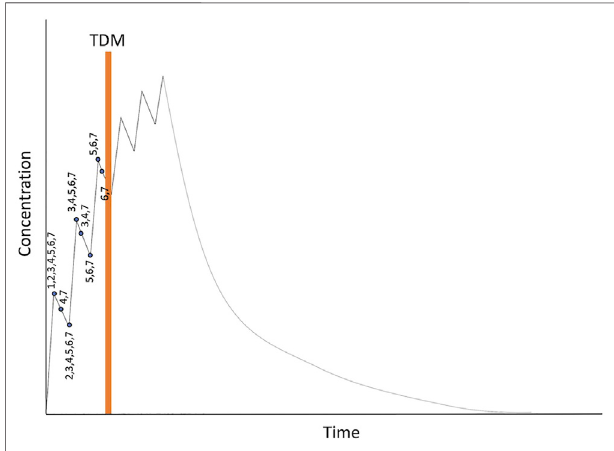
FIGURE2| Overviewofevaluateddosingregimens.Numbersrepresent the different dosing scenarios in Table 2 .